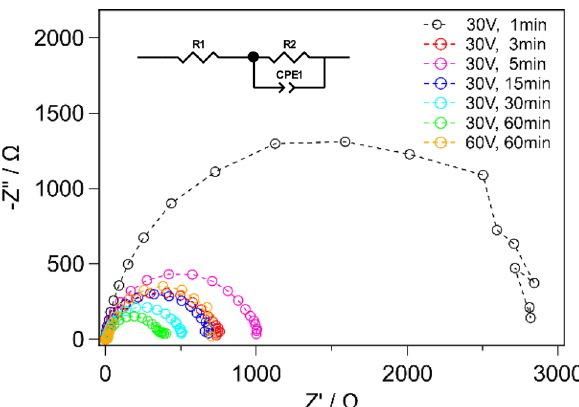
Figure 3. Nyquist plots of TNTAs prepared by different conditions of 2nd anodization.